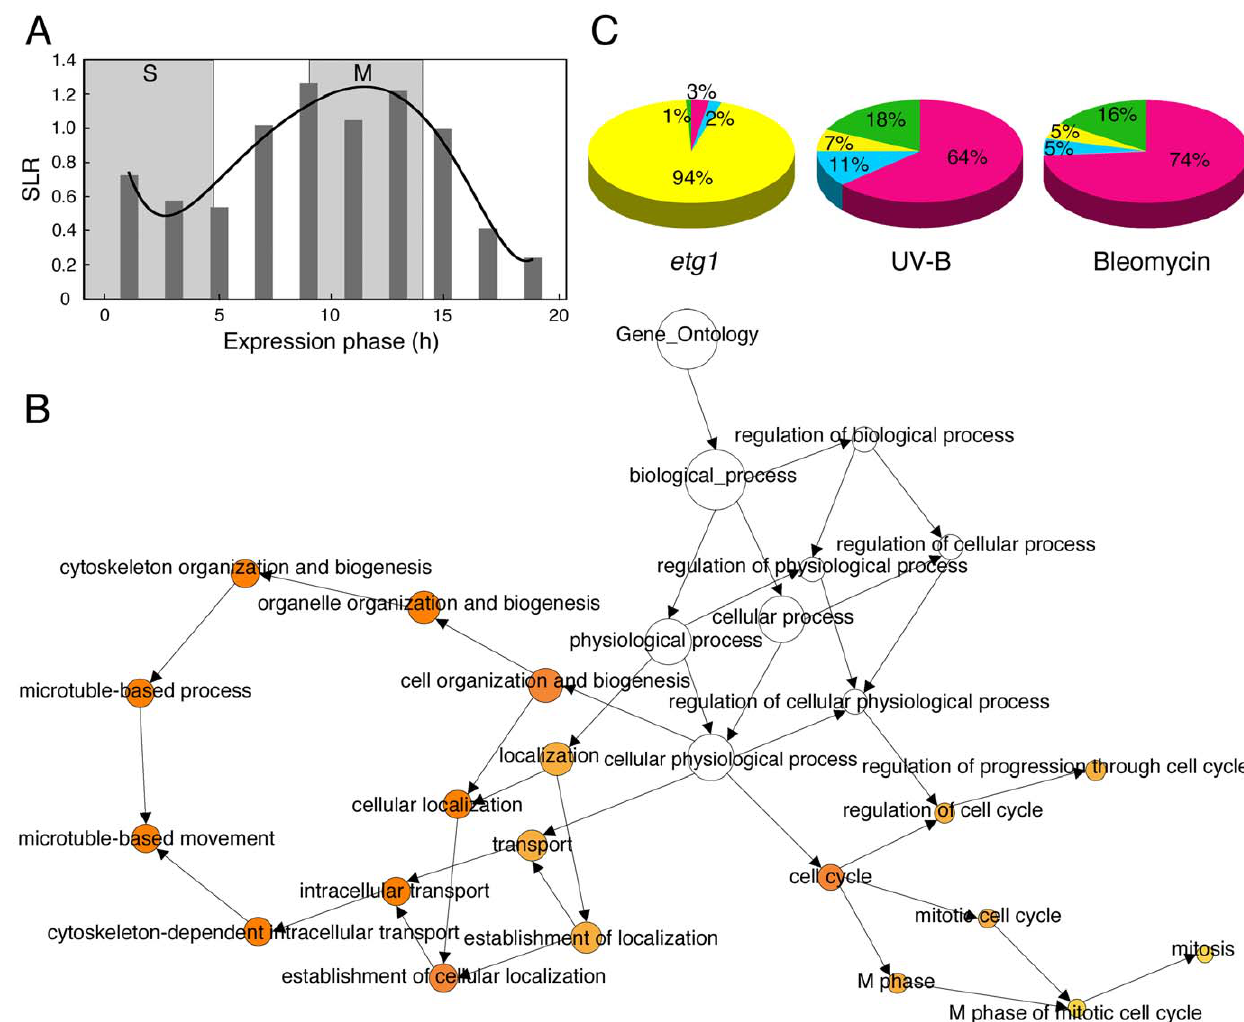
Figure 1. Upregulation of G2/M-specific genes in ETG1 -deficient plants. (A) Plot of average signal log ratios (SLRs; logarithms to the base 2) between wild-type and etg1 mutant plantsfor 9,910 genes during the22-h cell cycle of Arabidopsis [26]. Genes were sorted into10bins representingthe 10 time points of measurements, based on their maximal expression during the cell cycle. Cells were synchronized by a release from an aphidicolin arrest. Synchronized cells completed S phase in 5 h and went through mitosis from 9 to 14 h. The solid line represents the best-fitted curve. (B) GO analysis of the 196 upregulated genes in the first leaves of etg1 mutant plants. The yellow-to-orange color of the circles correspond to the level of significance of the overrepresented GO category of # 0.01 according to a multiple t test with false discovery rate–corrected P value. The size of the circle is proportional to the number of genes inthe category.(C) Comparisonof the distributionof cell cycle phase-dependent upregulated genes in etg1 plantsand plantstreatedwith UV-B- or bleomycin. Microarray data sets of UV-B, andbleomycintreatment were imported from [28] and [29], respectively. S (red), G2 (blue),M(yellow), and G1 (green) phase-specific gene expression patterns were defined by Menges et al. [26].